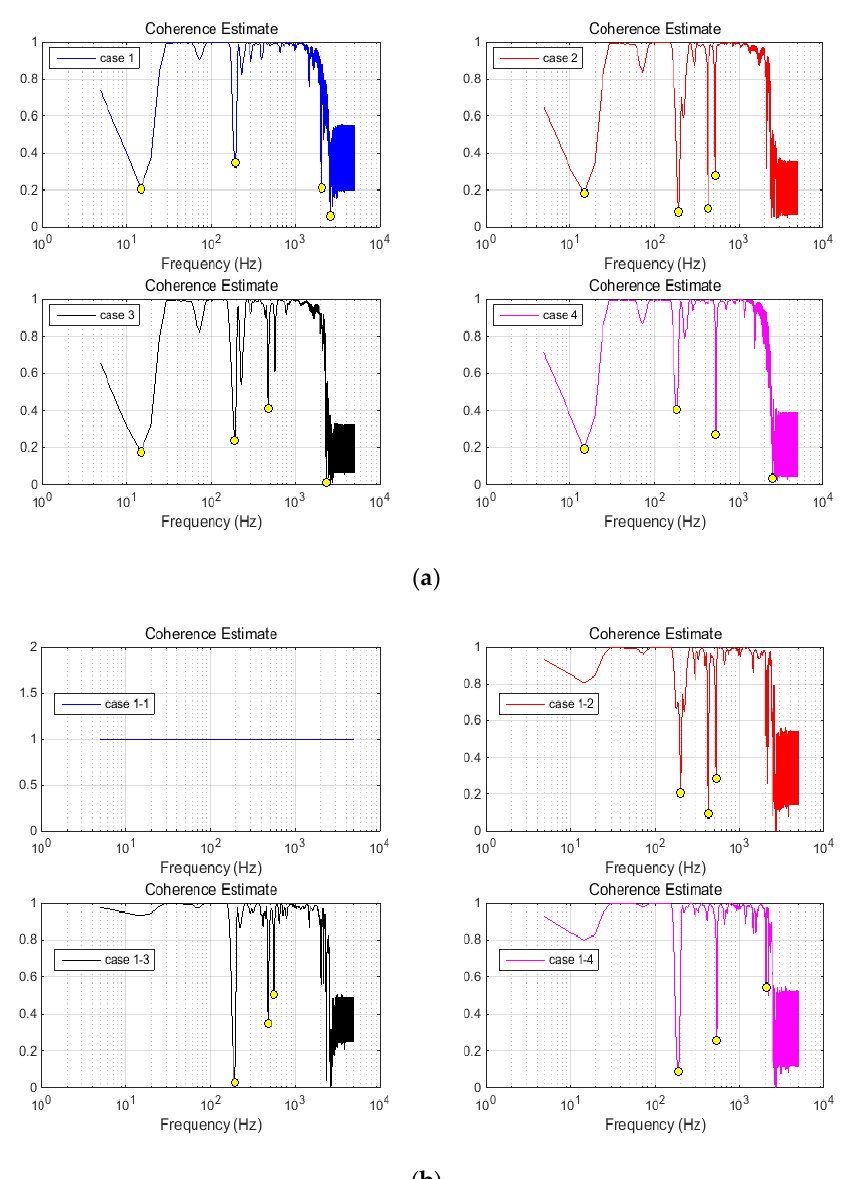
Figure 9. The coherence estimate of analyzed signals: ( a ) coherences between the input force and acceleration response for each case separately; and ( b ) coherences between the initial case and every other. Relevant minimum peaks are marked on diagrams.